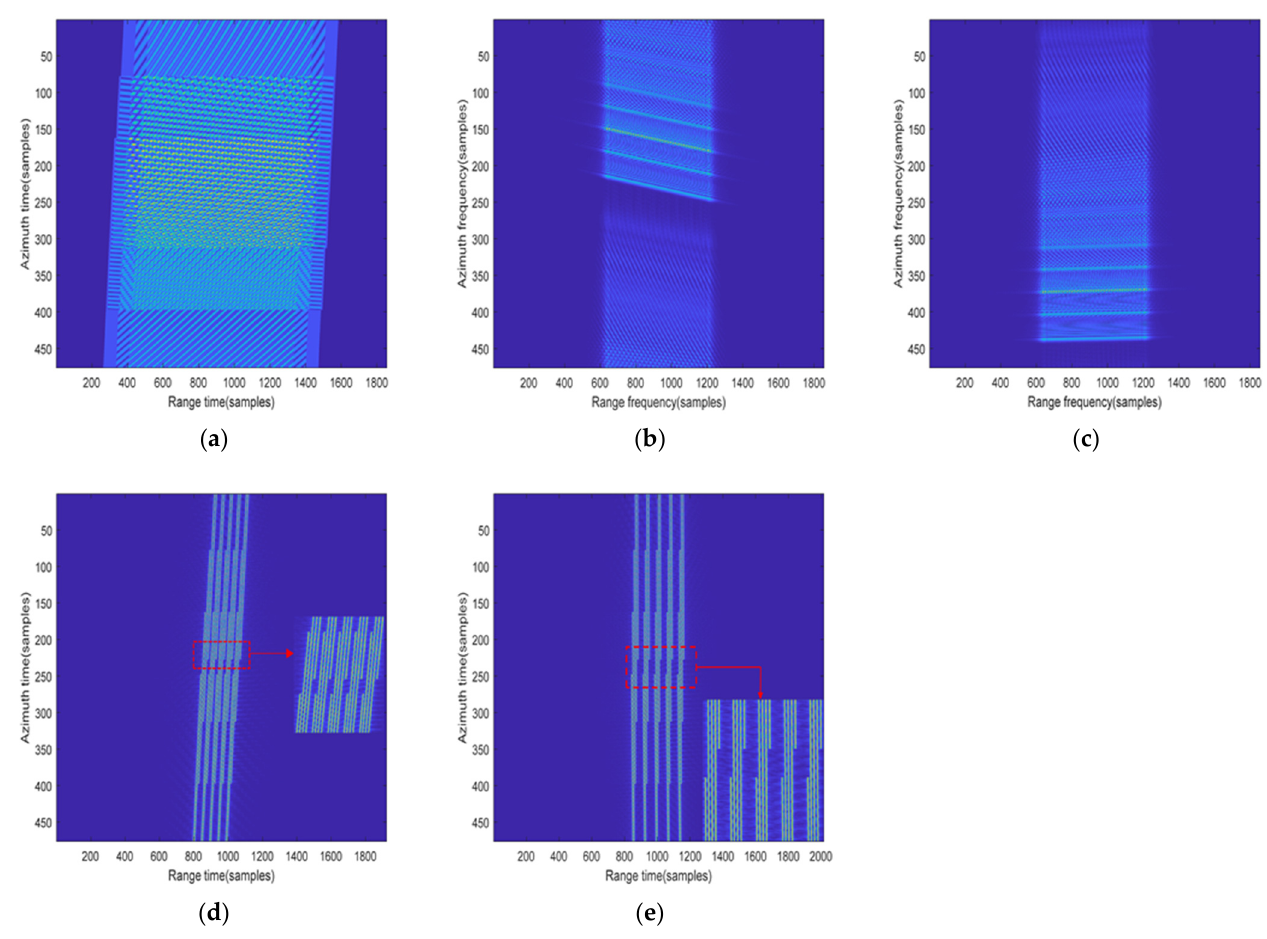
Figure 6. Illustration of the range operation in the proposed algorithm. ( a ) The original signal in the time domain; ( b ) the original signal in the two-dimensional frequency domain; ( c ) the two-dimensional spectrum after range migration correction; ( d ) the image of the signal after range compression; ( e ) the image of the signal after range compression and migration correction.